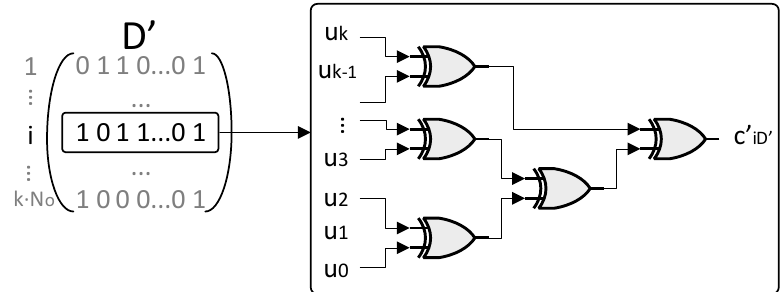
Figure 4. Tree fashion network implementing the logics described in the row D (cid:48)